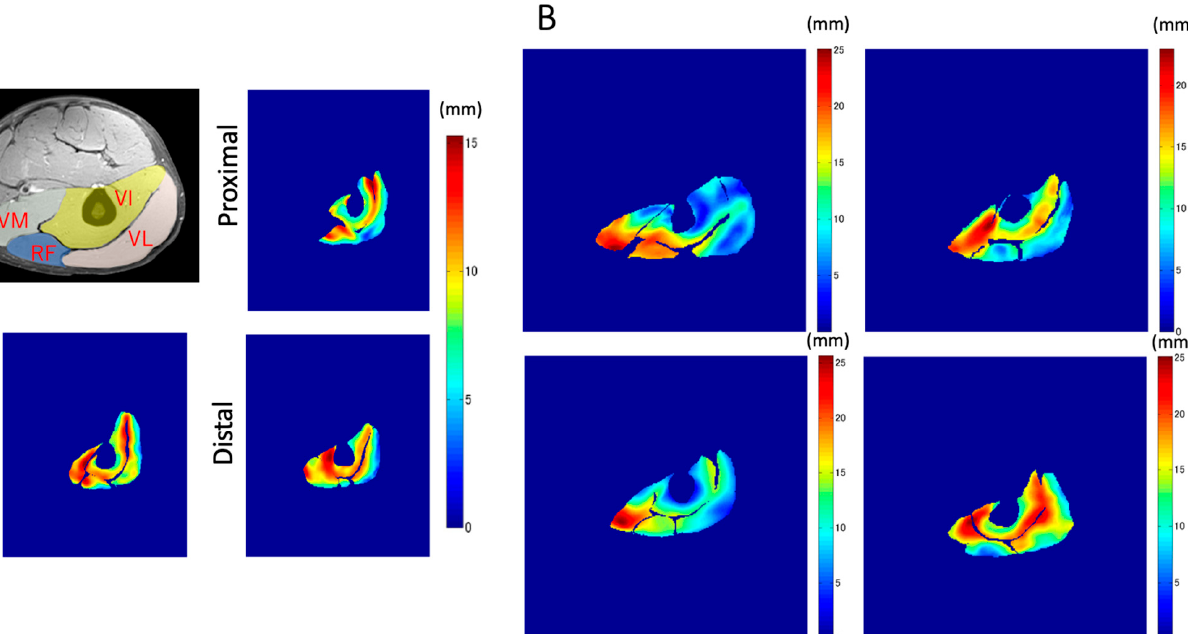
Figure 8. Examples of the Z -axis displacement at pixel level superimposed upon the static anatomical shape. ( A ) The distribution in the three different sections, proximal, middle, and distal in the same subject. ( B ) Examples of the middle section in four different subjects that clearly show all four muscles.